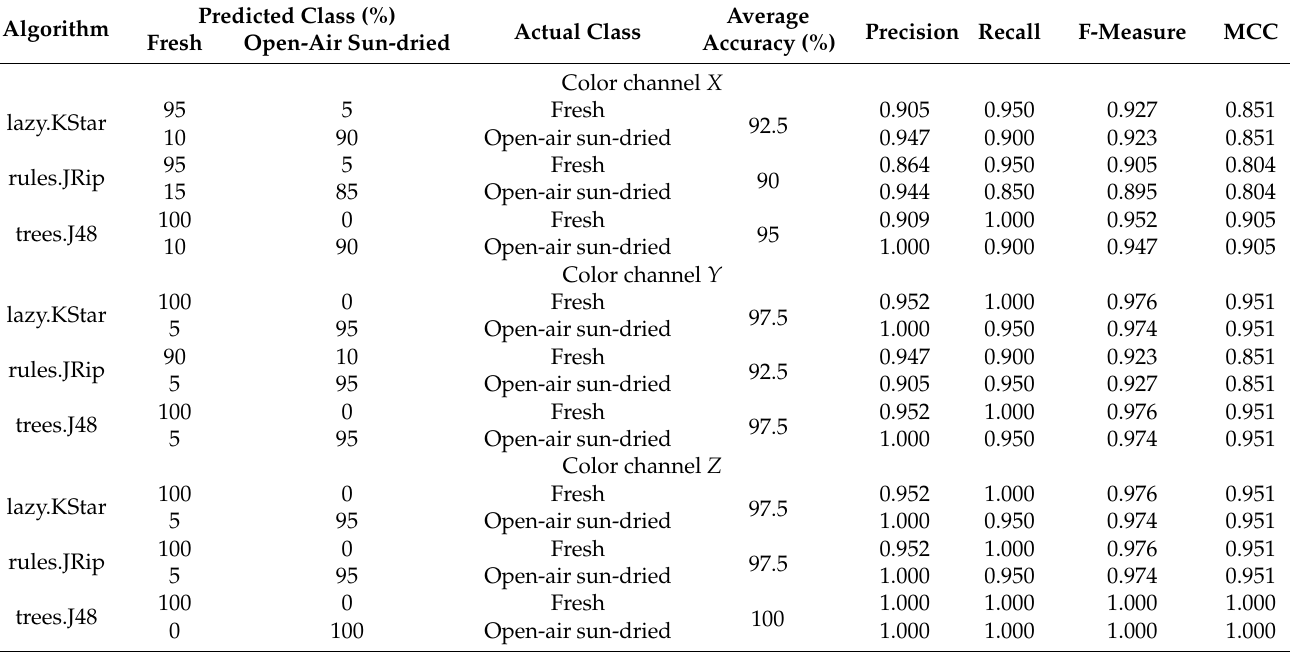
Table 12. The performance metrics of distinguishing fresh and open-air sun-dried mint leaves